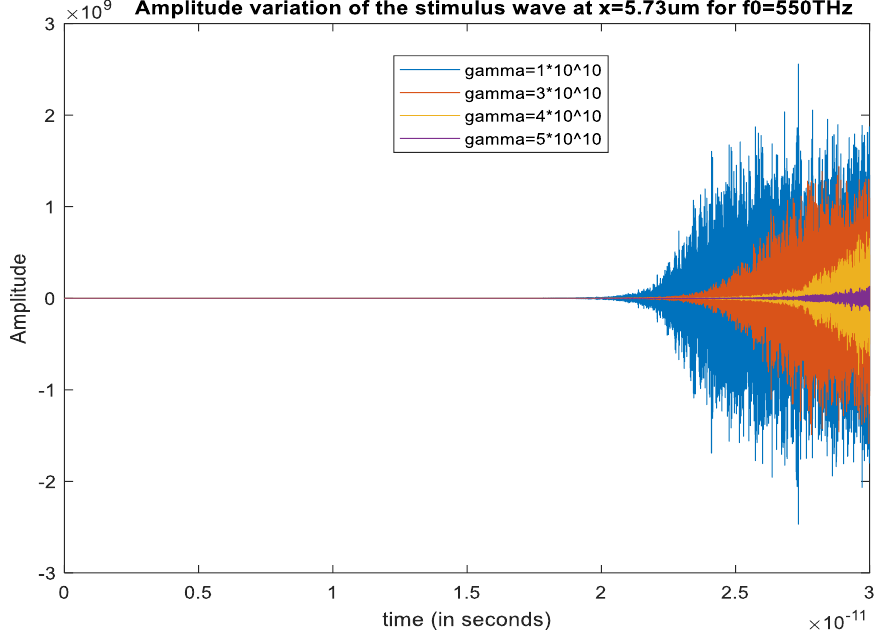
Figure 12. Stimulus wave amplitude variation inside the cavity at x = 5.73 µm, for { 𝛾 = 1 × 10 10 Hz , 𝛾 = 3 × 10 10 Hz, 𝛾 = 4 × 10 10 Hz,𝛾 = 5 × 10 10 Hz }, for a sample resonance frequency of 𝑓 0 = 550 THz.